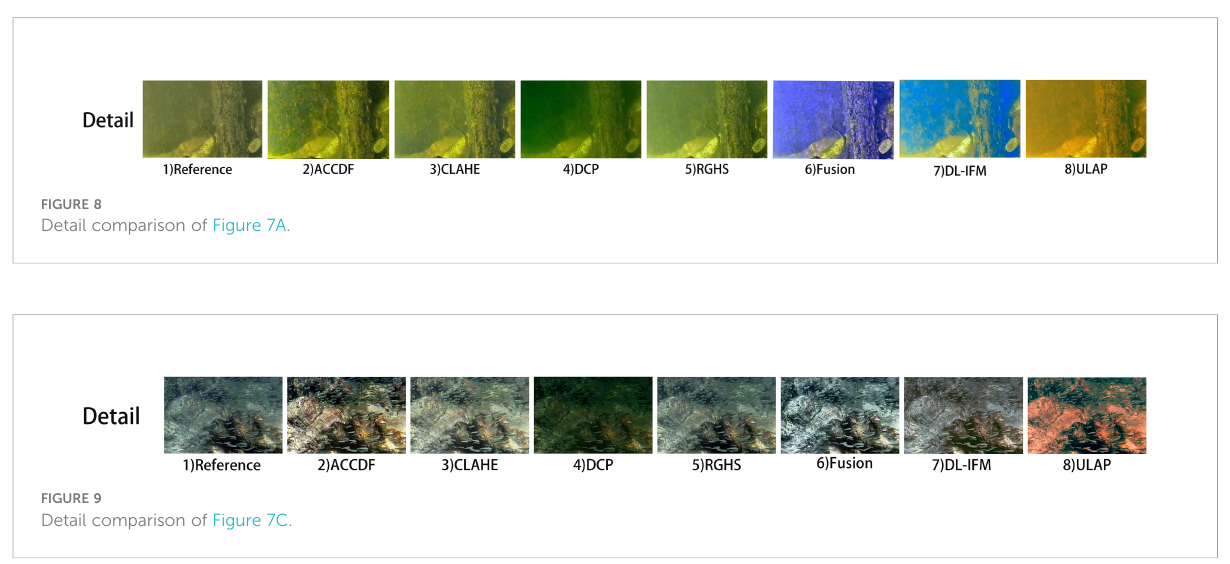
FIGURE 9 Detail comparison of Figure 7C.